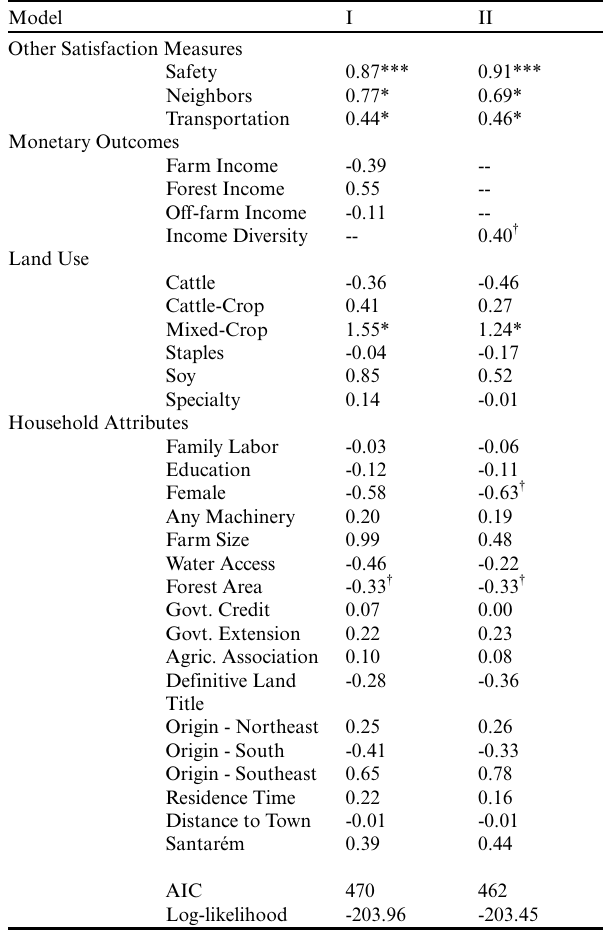
Table 3 . Results for ordered logit subjective well-being